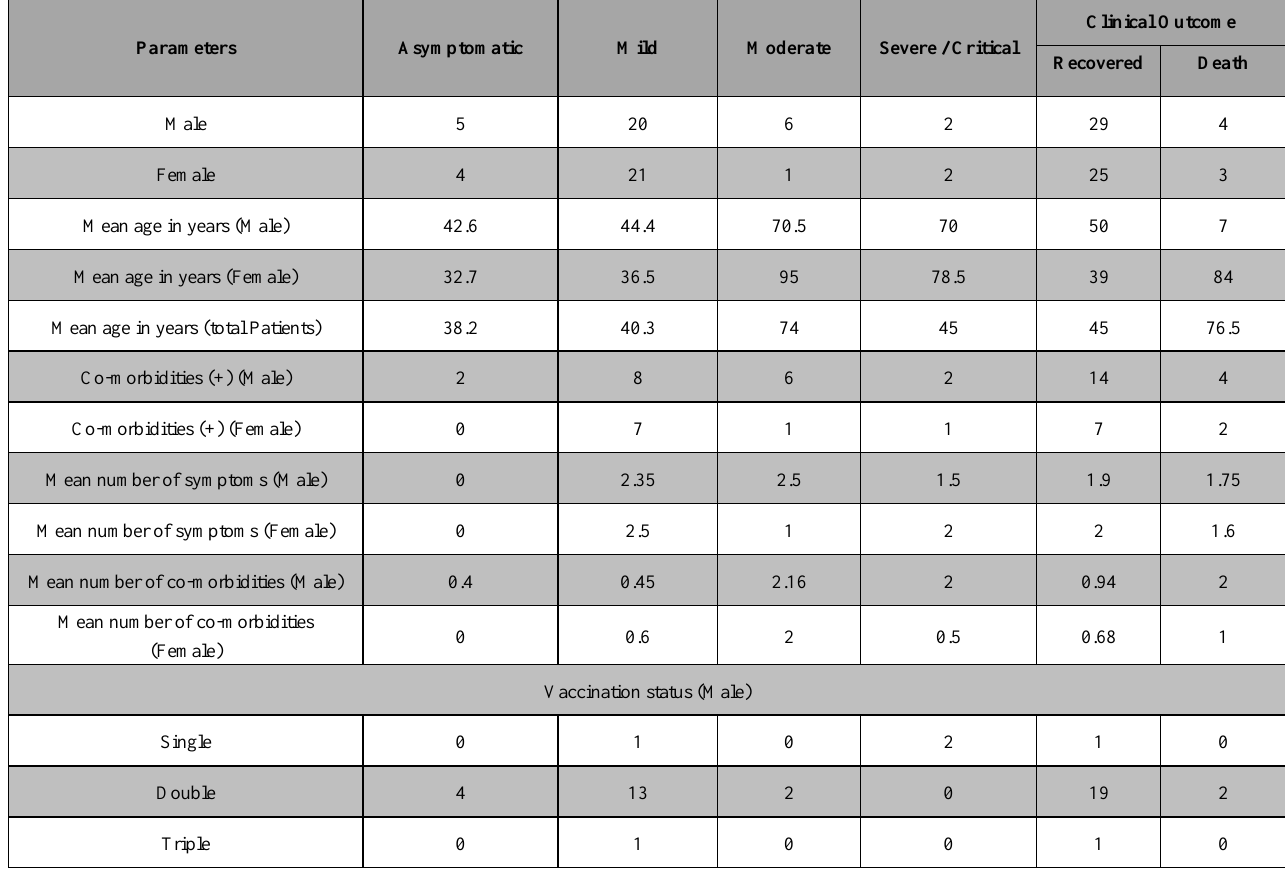
Table 2. Clinical category-wise distribution of various parameters taken in the